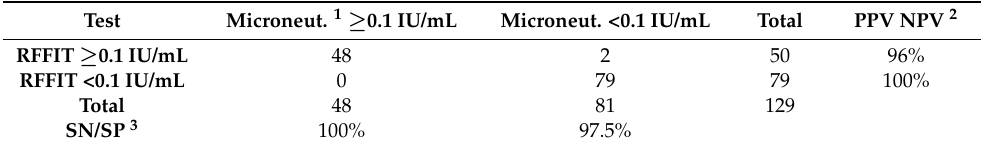
Sensitivity, specificity, as well as positive and negative predictive value of the micro-neutralization test compared to the rapid fluorescent focus inhibition test (RFFIT).